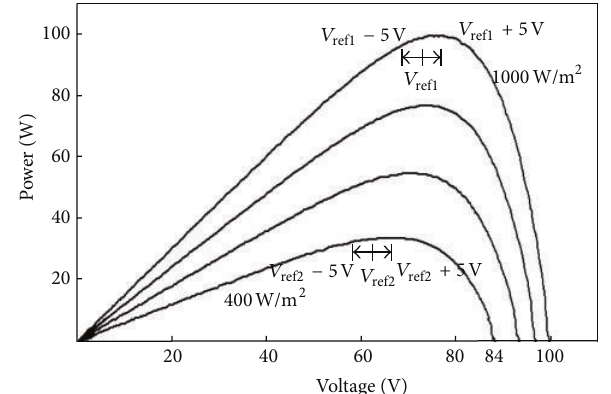
Figure 5: 𝑃 - 𝑉 curves obtained from the PV